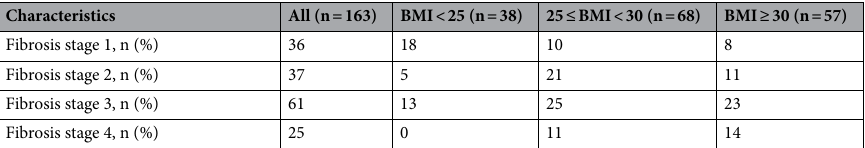
Table 1. Patient characteristics. Data are presented as means ± standard deviations. AAR AST to ALT ratio, ALT alanine aminotransferase, APRI AST to platelet ratio index, AST aspartate aminotransferase, BMI body mass index, CAP controlled attenuation parameter, FIB-4 fibrosis 4, GGT γ-glutamyl transpeptidase, LSM liver stiffness measurement, MRE magnetic resonance elastography, MRI magnetic resonance imaging, MRI-PDFF magnetic resonance imaging-proton density fat fraction, NAFLD nonalcoholic fatty liver disease, NAS NAFLD activity score, NFS NAFLD fibrosis score, PCD probe-to-liver capsule distance, NFS non-alcoholic fatty liver disease fibrosis score, VCTE vibration-controlled transient elastography.